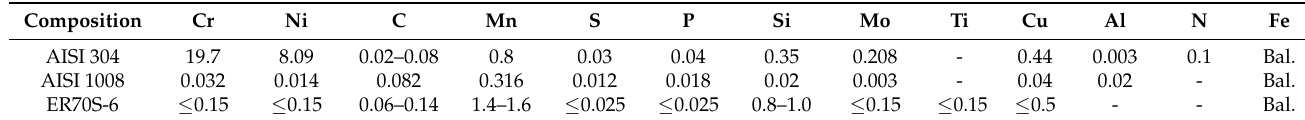
Table 2. Chemical composition of base metal and filler material (% by wt.).